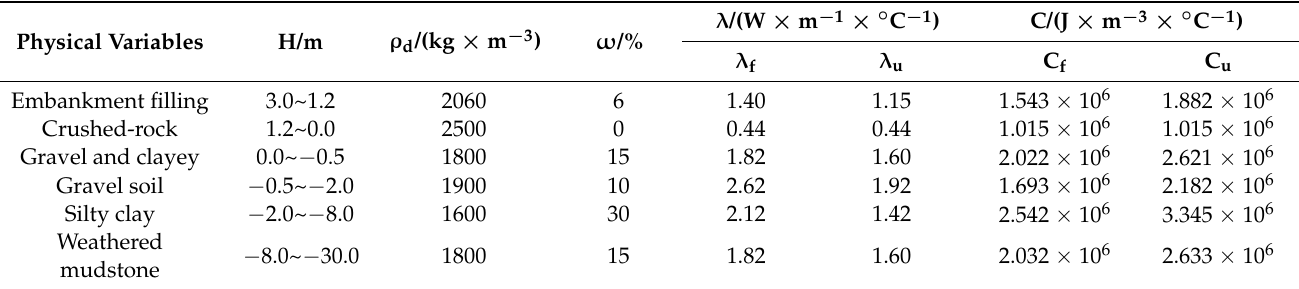
Table 3. Thermal parameters of the soil layers in the embankment model.